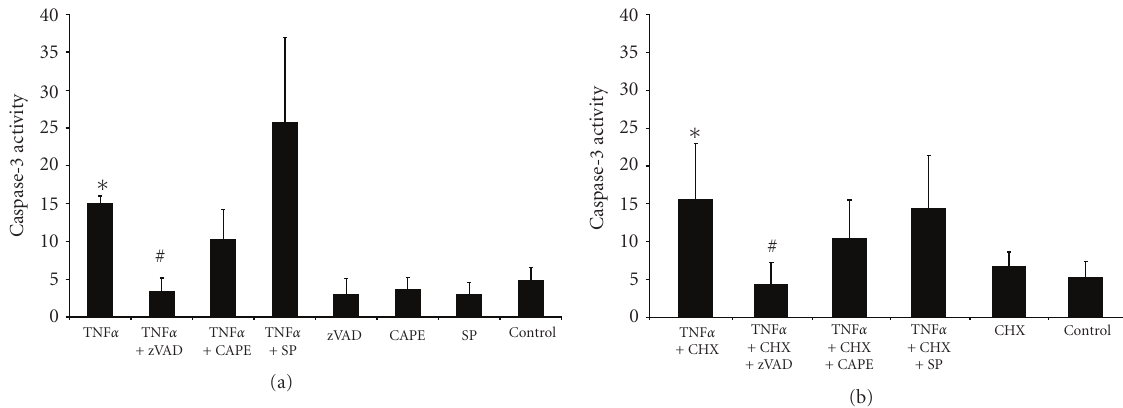
Figure 6: TNF α strongly activates caspase-3 in PCPEC. Caspase-3 activation (given as change of fluorescence per minute in arbitrary units ( Δ FU/min.)) was measured in PCPEC after stimulation with TNF α (100 ng/mL) for 24 hours with and without zVAD (10 μ M), CAPE (5 μ M) or SP600125 (10 μ M) preincubation for 2 hours (a), and coincubation with cycloheximide (CHX) (1 μ g/mL) (b) and unstimulated control. The data shown are mean ± SEM of three independent experiments ( n = 3), each performed in duplicates. ∗ P-value of < . 05 compared to unstimulated PCPEC; # P-value of < . 05 compared to TNF α ± CHX stimulated PCPEC without